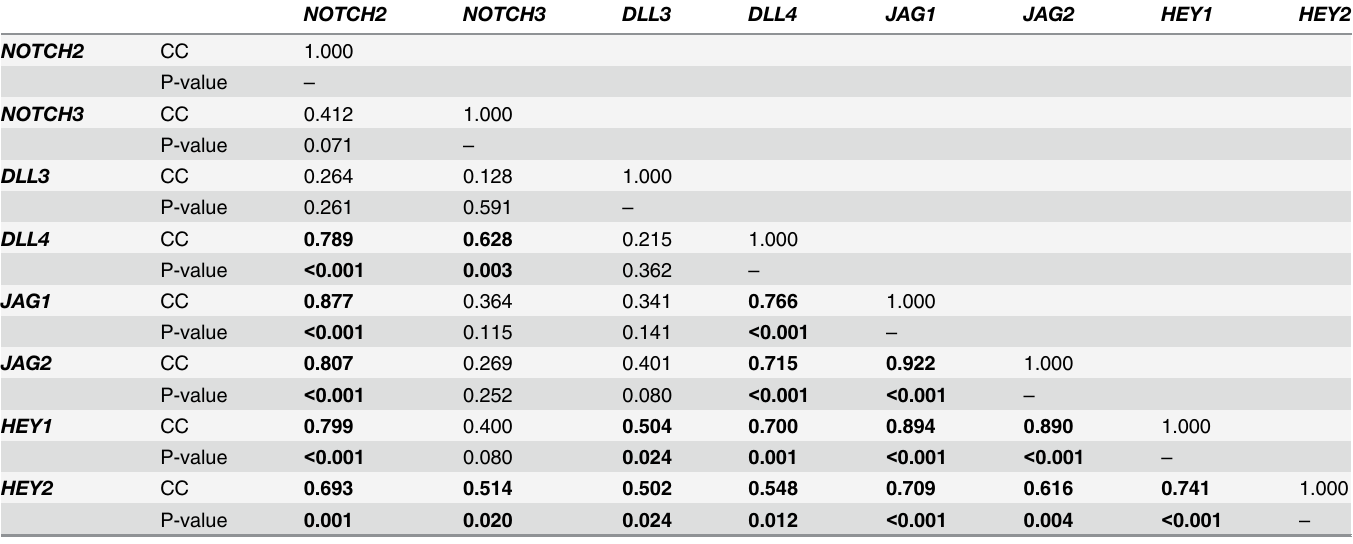
Table 5. Notch signaling pathway pair-wise mRNA co-expression analysis in preeclamptic